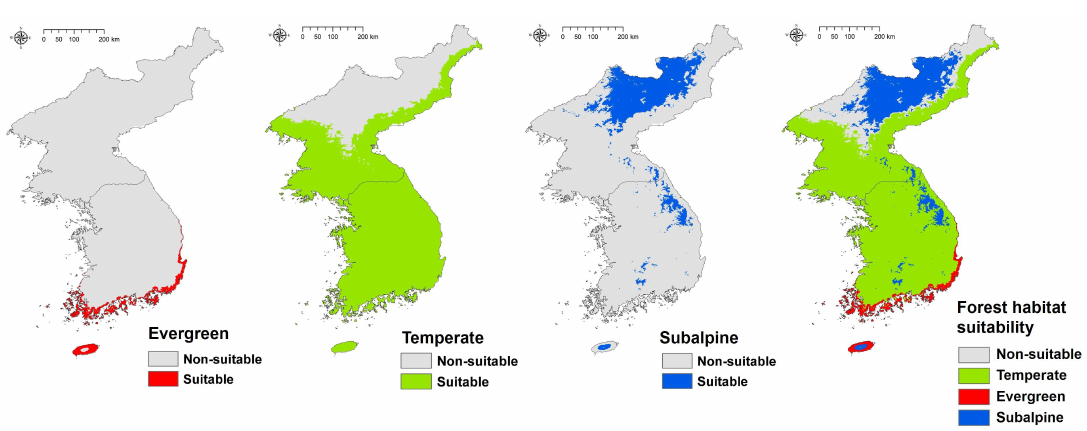
Figure 3. Results of forest habitat suitability by type at the baseline period.